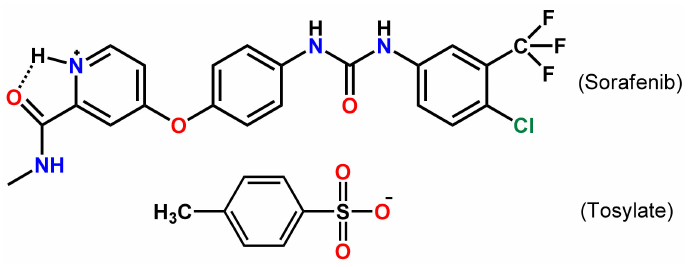
Figure 1. Molecular structure of sorafenib